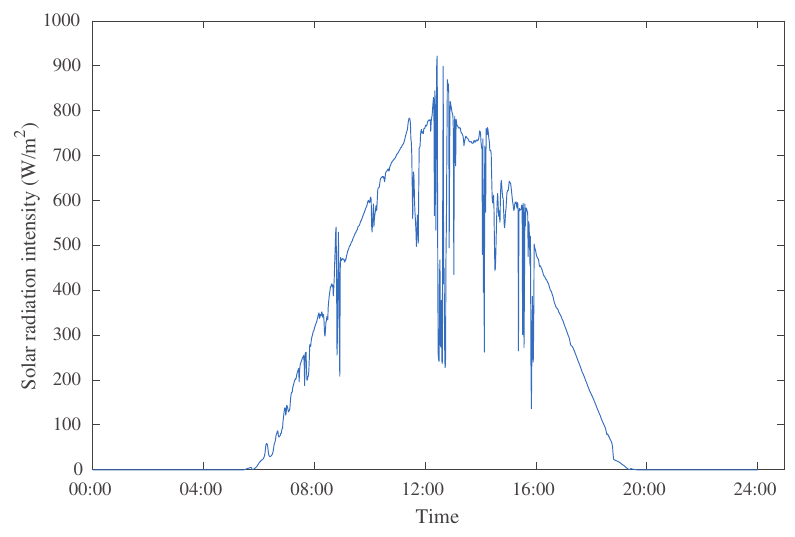
Figure 2. Monitoring data of solar radiation